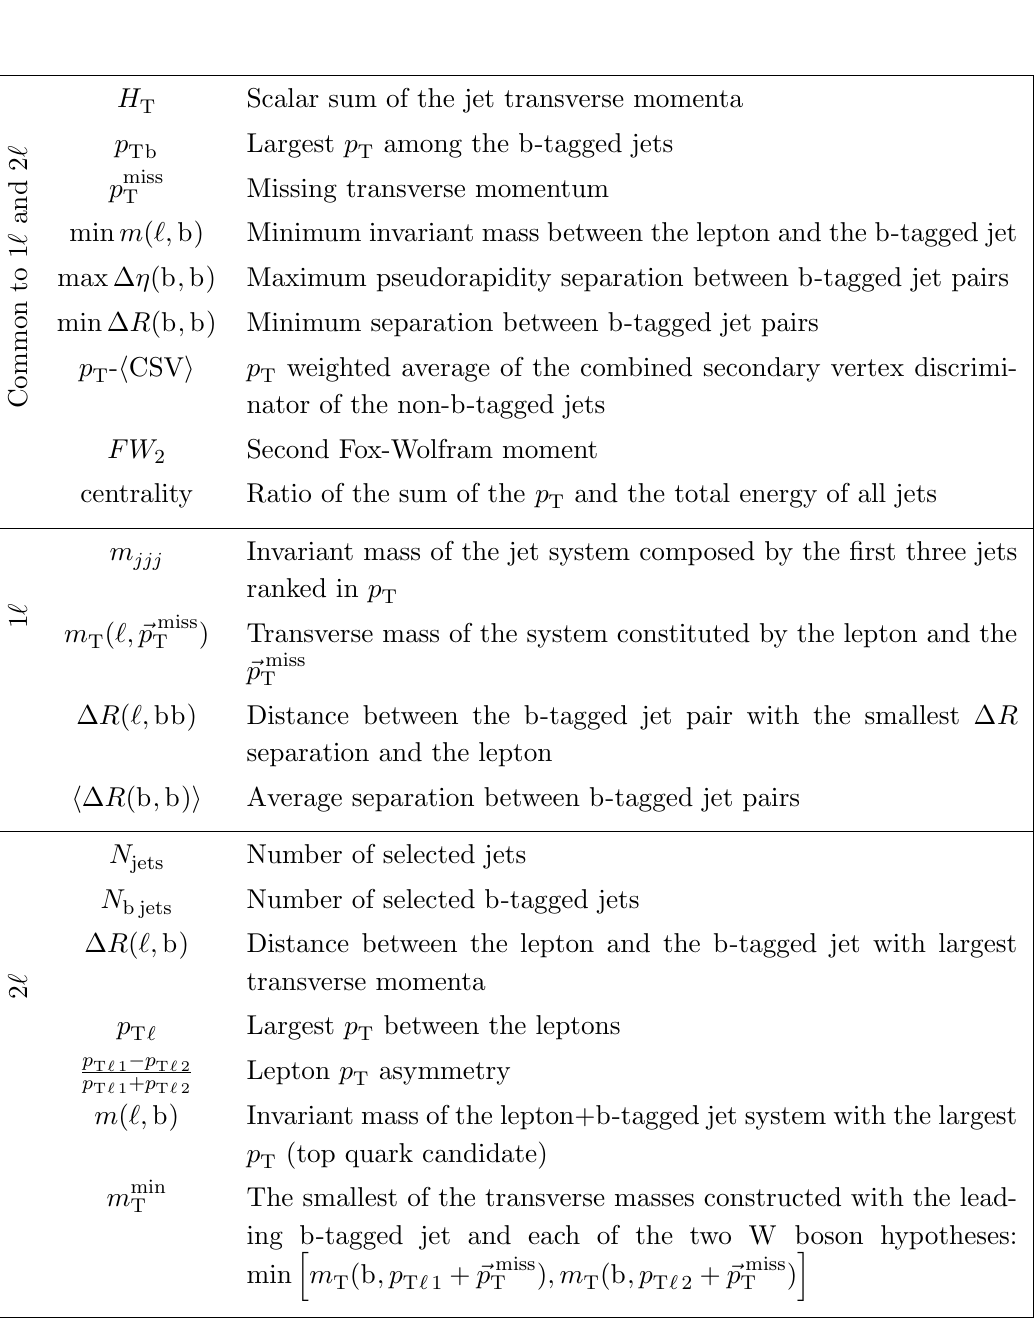
Table 1 . Summary of the discriminating variables used in the analysis of the single-lepton (1 ‘ ) and dilepton (2 ‘ ) (cid:12)nal states. lepton p asymmetry, the mass of the lepton+b-tagged jet system with the largest p T the smallest of the transverse masses constructed with the leading b jet and each of the two W boson hypotheses, where the W bosons are reconstructed using the ~p miss lepton